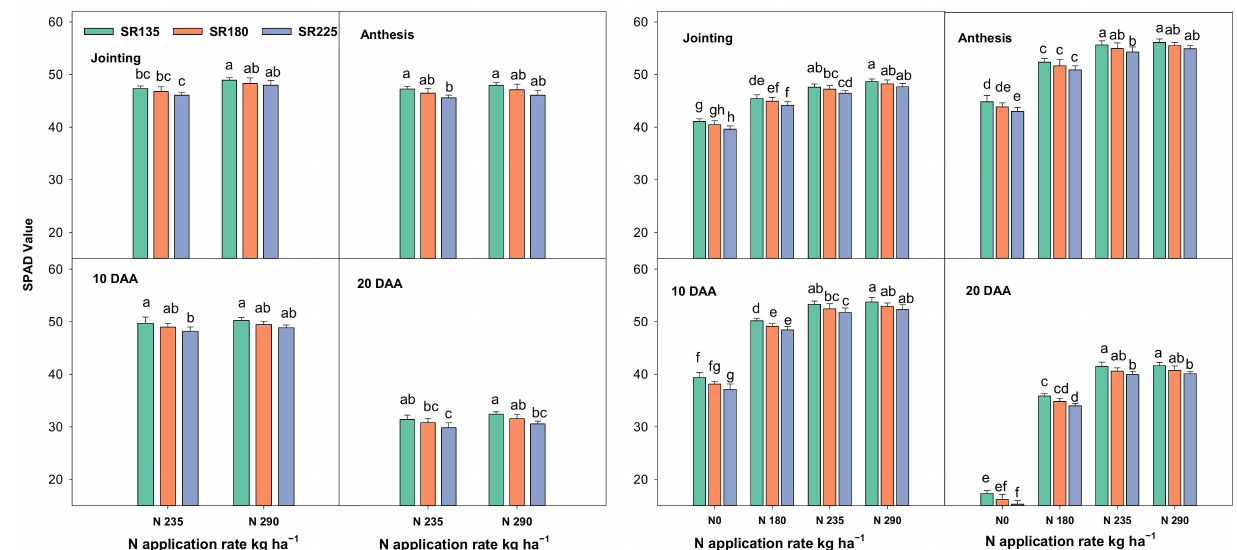
Figure 2. Effects of N and SR on chlorophyll content (SPAD) during four differnet growing stages in 2017–2018 and 2018–2019. Different letters represent significant differences in mean values of three replicate plots at p ≤ 0.05 levels according to Duncan’s